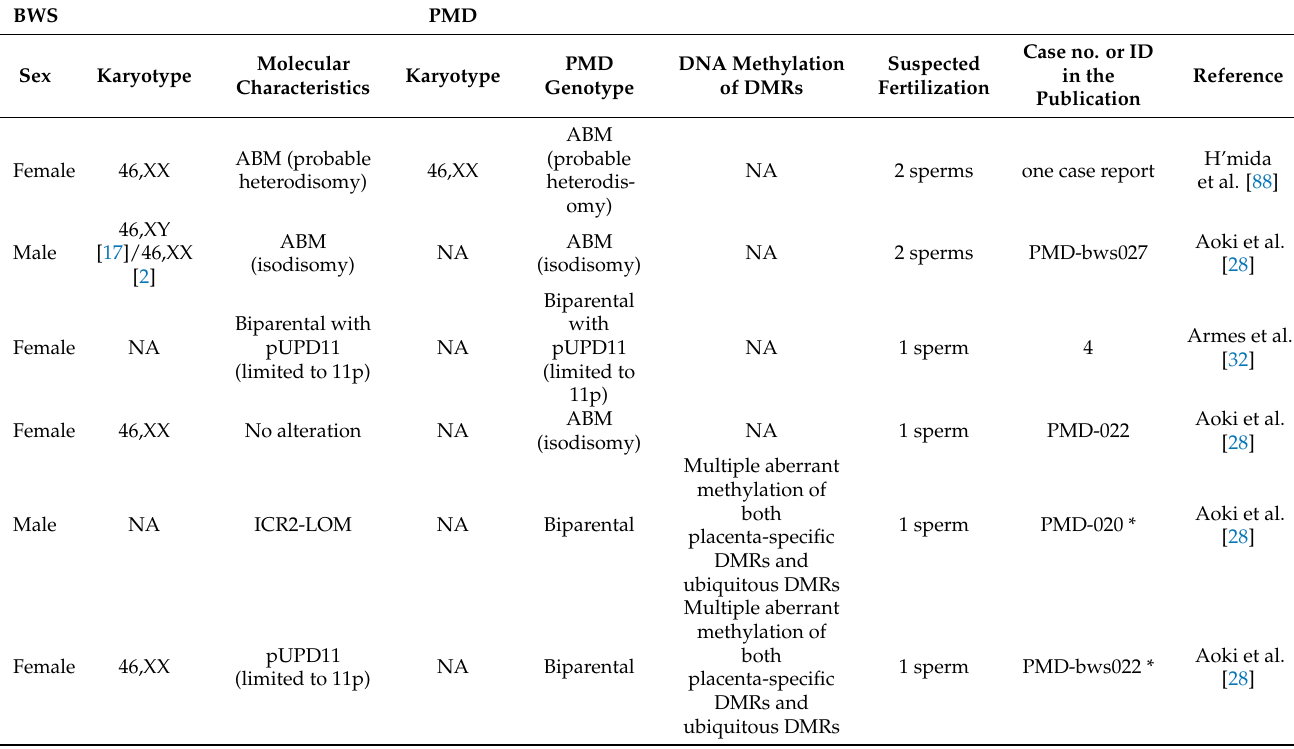
Table 1. Molecular characteristics of BWS and